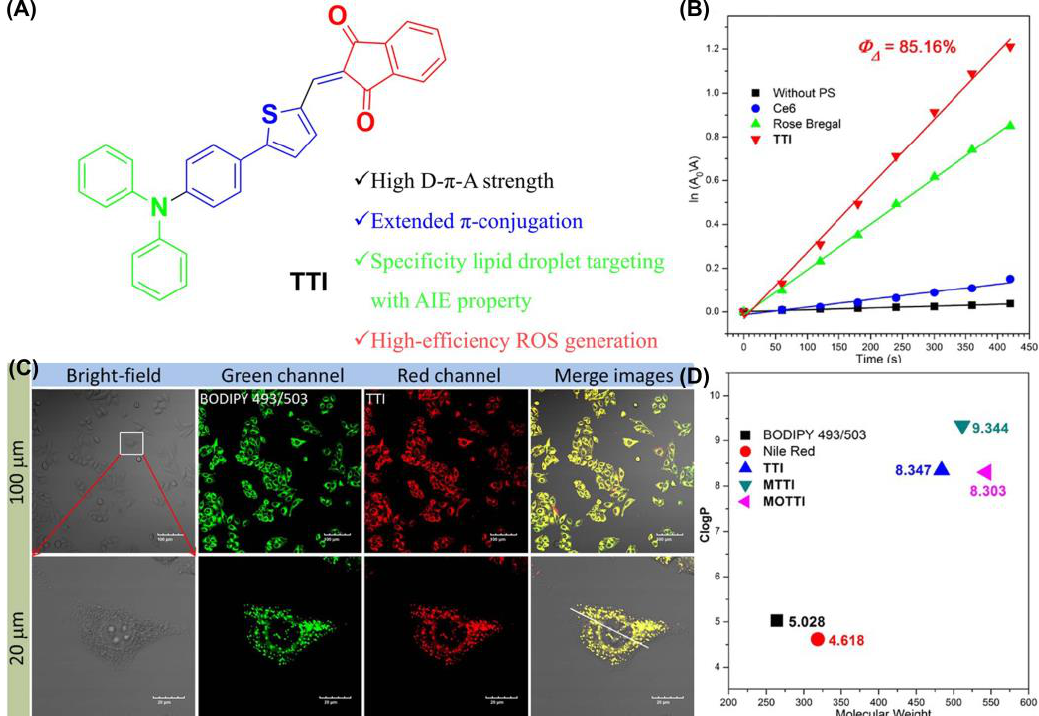
Figure 11. ( A ) Chemical structure and functions of TTI; ( B ) 1 O 2 quantum yield with TTI and Clog p values of TTI; ( C ) CLSM images of HepG2 cells stained with TTI and BODIPY 493/503; ( D ) Clog p values of TTI and its derivatives. Reprinted with permission from Ref. [119]. Copyright 2021 Elsevier